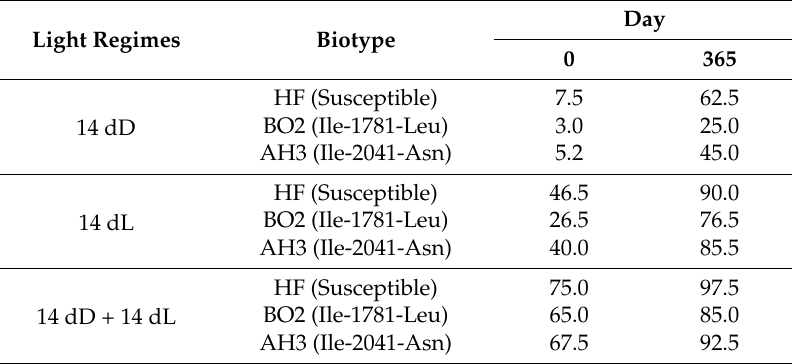
Table 2. Final germination of the HF (S), BO2 (Ile-1781-Leu) and AH3 (Ile-2041-Asn) populations at diverse after-ripening times at 11/21 ◦ C and under three light treatments: two weeks darkness (14 dD), exposure to 12 h light (14 dL), and dark imbibed for 14 days followed by disposal for 14 days to 12 h light (14 dD + 14 dL).